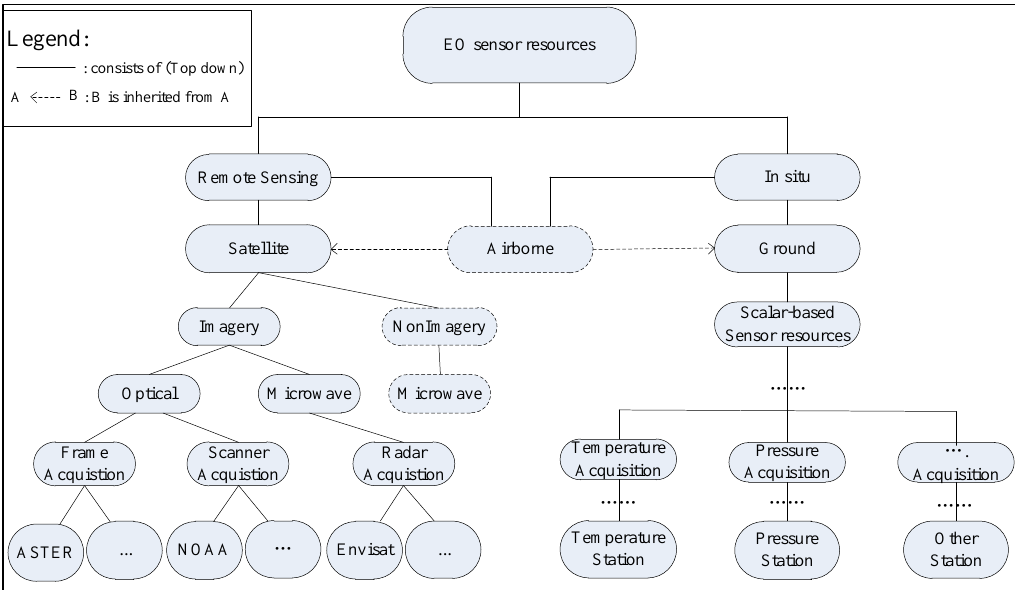
Figure 3. Classification scheme of EO sensor